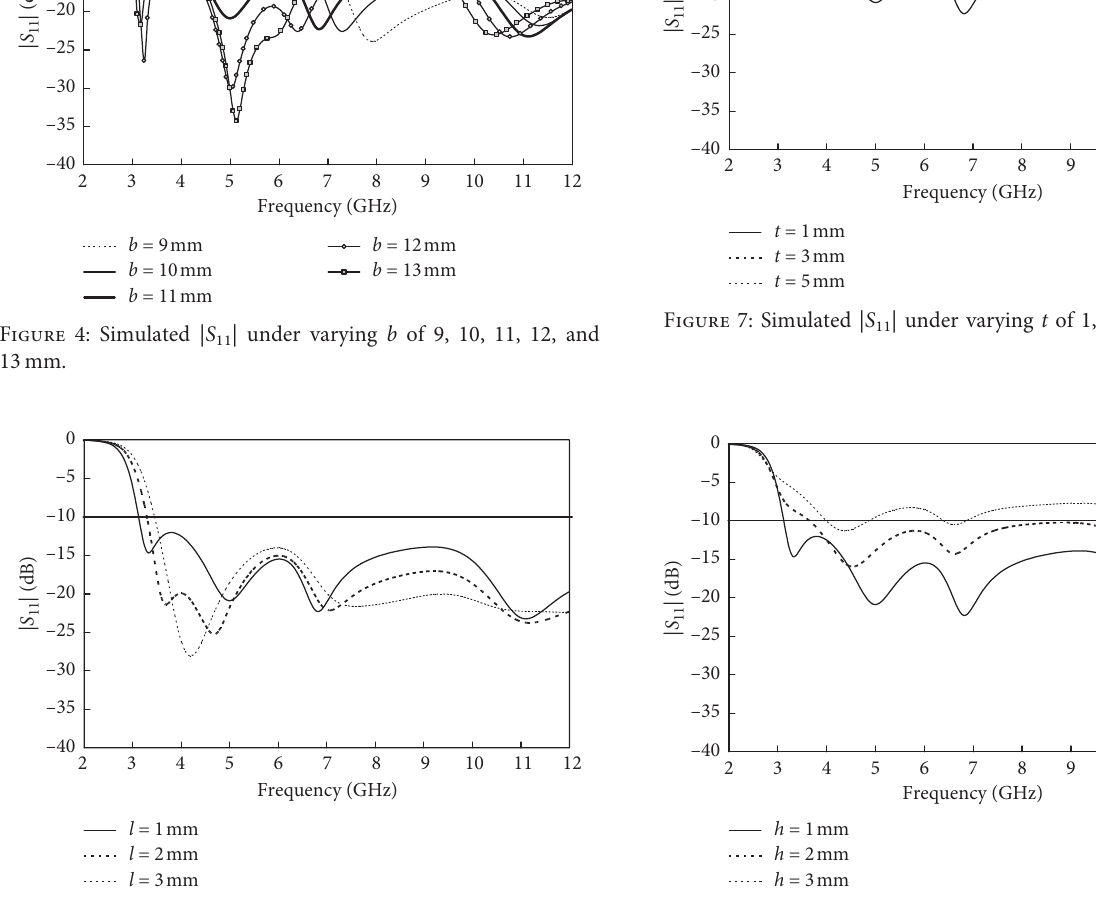
Figure 5: Simulated | S 11 | under varying l of 1, 2, and 3mm.